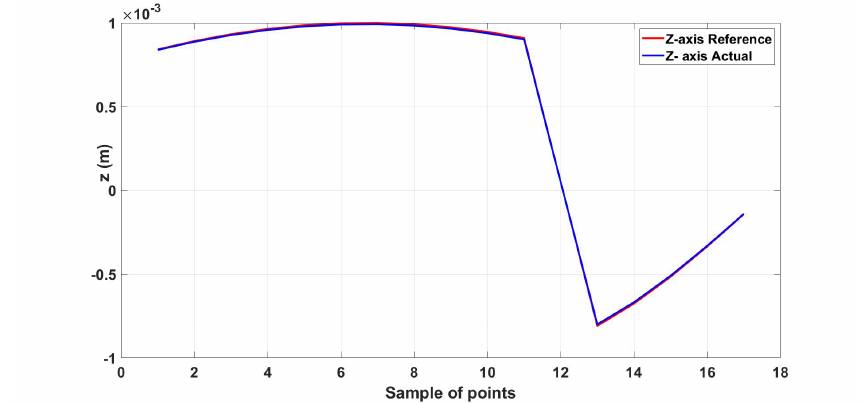
Figure 14. Actual and reference position of the diamond trajectory in the